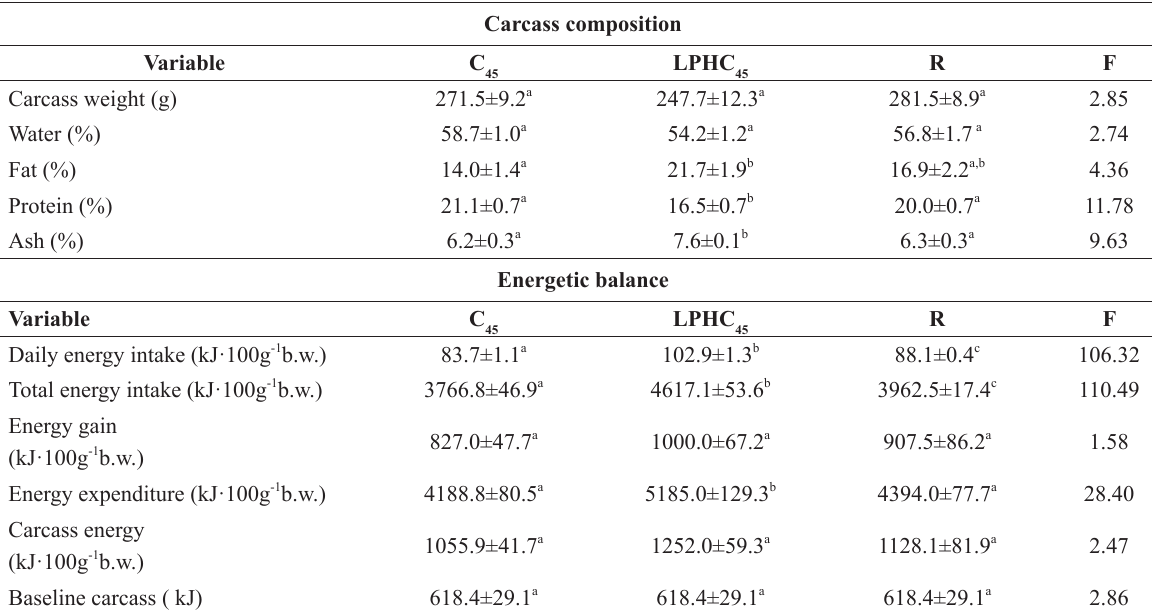
Carcass composition and energetic balance in C